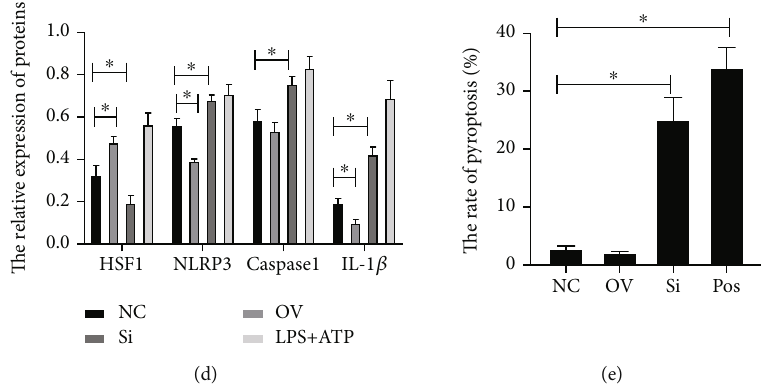
Figure 6: HSF1 regulates the pyroptosis of PC12 and the expression of NLRP3. (a) Real-time PCR was used to detect the expression of HSF1, NLRP3, and IL-1 β in PC12 cells. (b, d) Western blot was used to detect the expression of the in fl ammatory cytokines and pyrolytic proteins in di ff erently treated PC12, ∗ p < 0 : 05 . (c, e) EthD-III staining (red) was labeled as pyroptosis, and Hoechst staining (blue) was tagged as nuclei, ∗ p < 0 : 05 . NC: negative control group; OV: hsf1 overexpression group; si: hsf1 silence group; LPS+ATP: PC12 cells treated with LPS for 12 hours and ATP for 1 h. Scale bar: 100 μ m, apply to all the